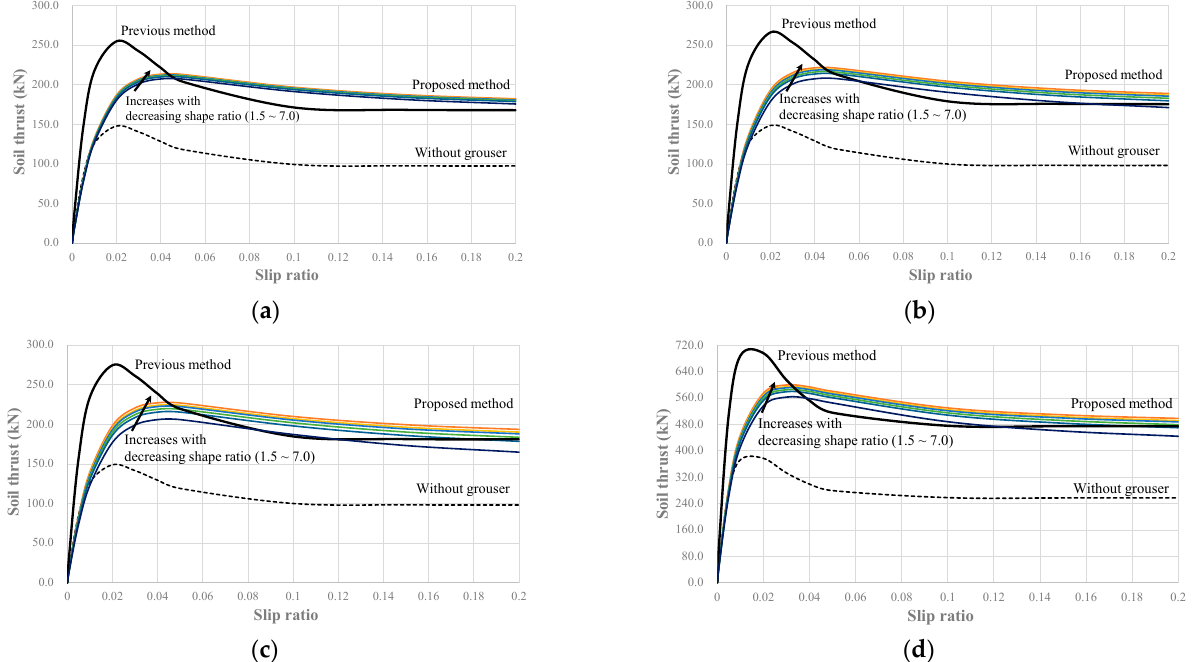
Figure 9. Soil thrust and slip displacement curves in soils exhibiting softening behavior ( c = 2.2 kPa, 𝜙 = 39.4° , K W = 6.1, K r = 0.659): EC145E with a grouser height of ( a ) 25 mm ( b ) 50 mm ( c ) 70 mm: ( d ) EC380E with 70 mm grouser height.